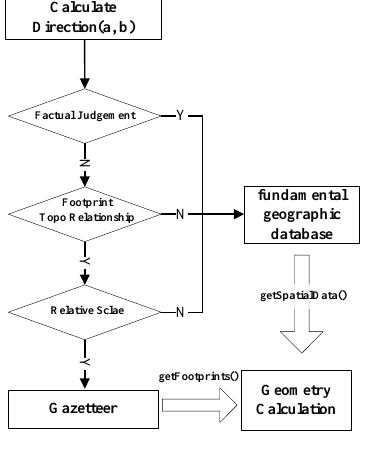
Figure 2 The extraction algorithm